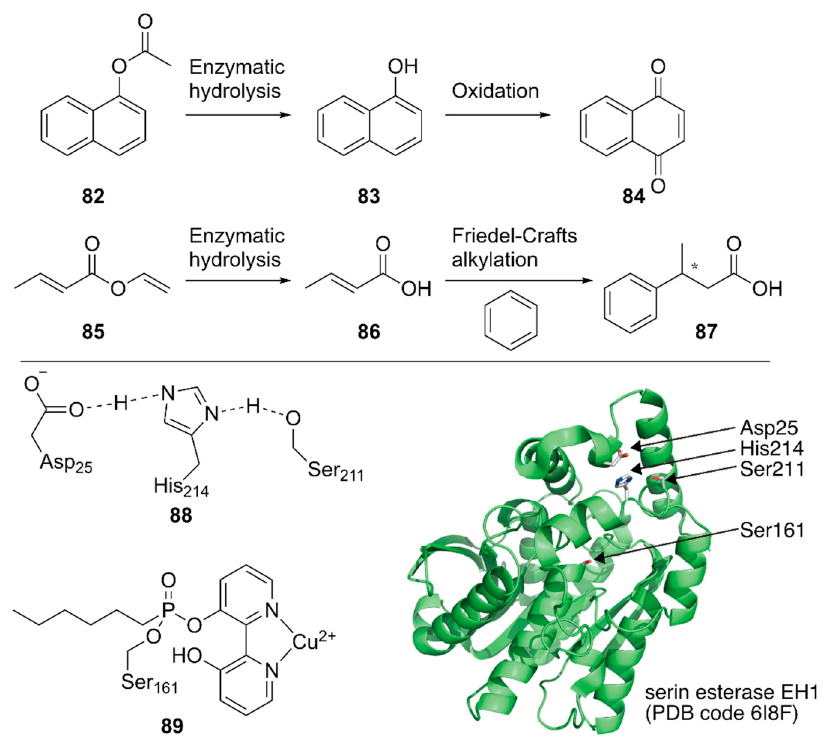
Figure 17. Chemoenzymatic cascade reactions catalyzed by an artificial enzyme with two active sites. Adapted from [113].